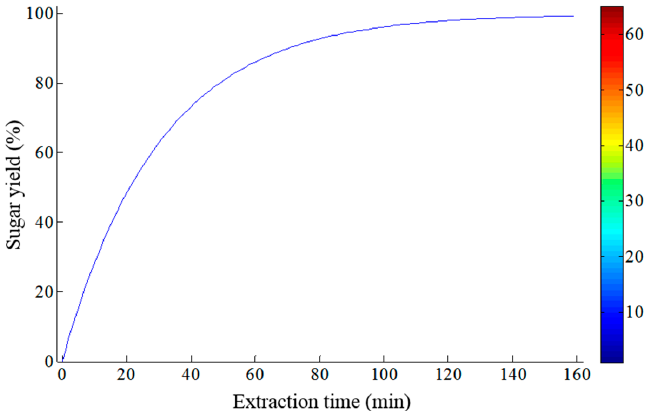
Figure 3. Kinetics of extraction of sugar from sweet sorghum biomass (color code indicates the concentration of sugars in the bulk solution (g/L)).